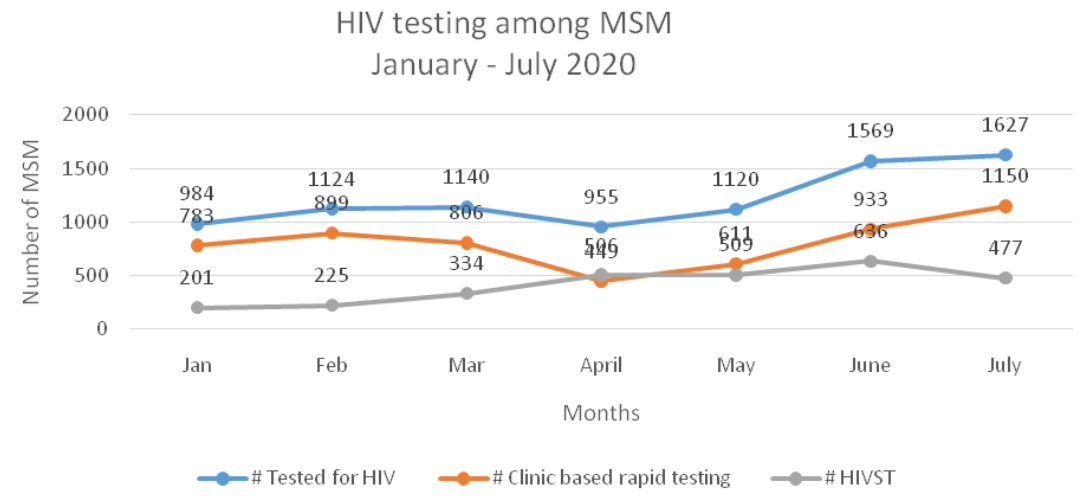
Figure 8. HIV testing among MSM, by type of test, in three sites (combined program data, Jan–July